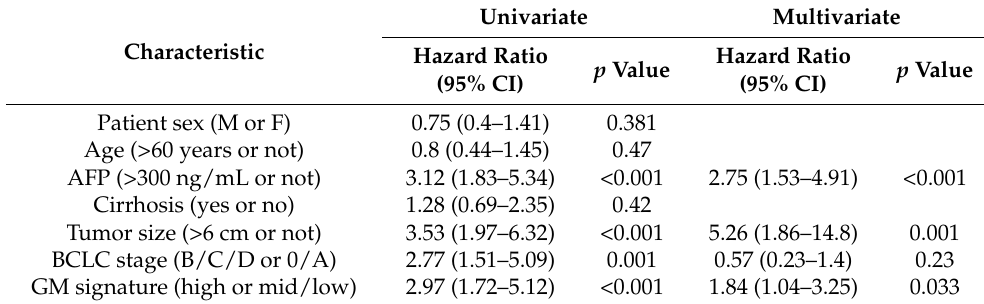
Table 1. Univariate and multivariate Cox regression analyses of overall survival in Zhongshan cohort.